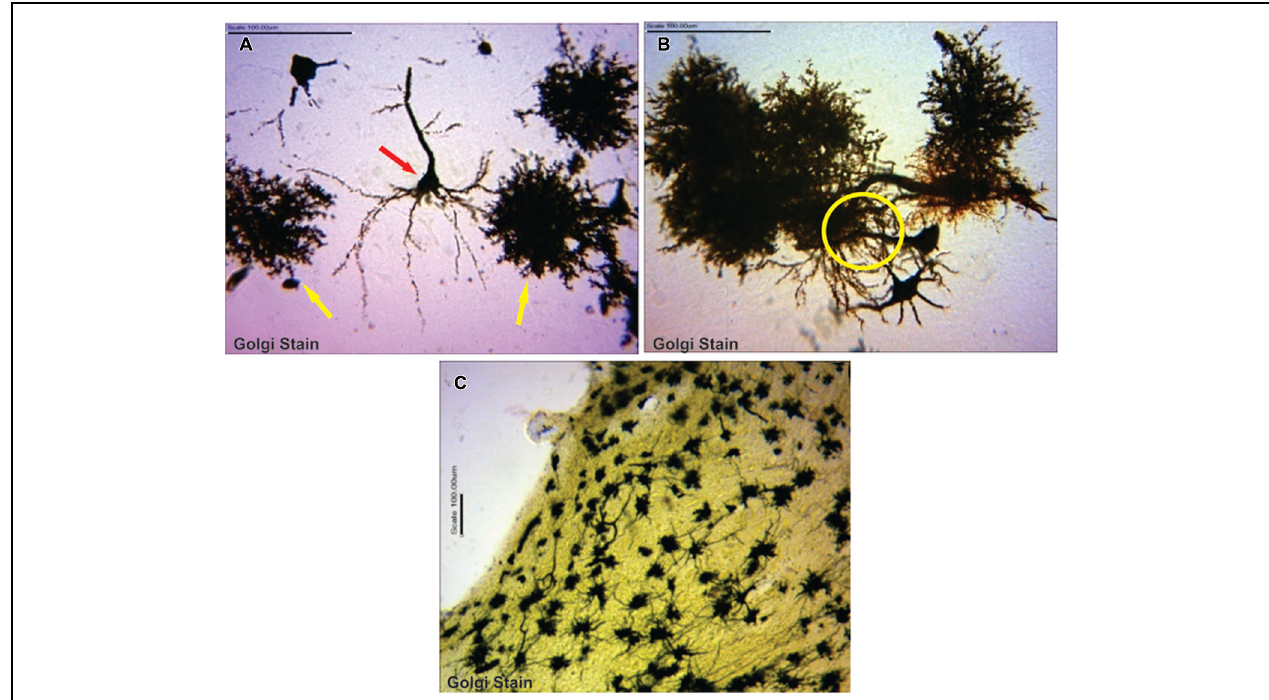
FIGURE 1 | (A) Typical pyramidal neuron (red arrow) making association with astrocytes (yellow arrows; B ) astrocytes in synaptic association with neurons (circumscribed area; C ) astrocytes immunolabelling in the cerebellum.